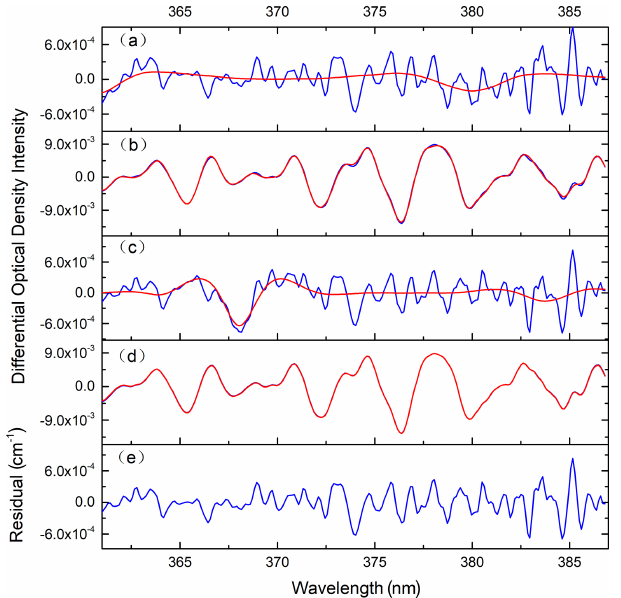
Figure 6. Examples of the spectral retrieval of O 4 , NO 2 , and HONO in the measured atmosphere: (a) the blue line shows the absorp- tion spectrum of O 4 , and the red line shows the fitting spectrum; (b) the blue line shows the absorption spectrum of NO 2 , the red line shows the fitting spectrum, and the retrieved NO 2 concentra- tion is 29.18ppbv; (c) the blue line shows the absorption spectrum of HONO, the red line shows the fitting spectrum of HONO, and the retrieved HONO concentration is 0.78ppbv; (d) the blue line shows the differential optical density line, and the red line shows the fit- ting differential optical density; (e) the blue line shows the fitting residuals.